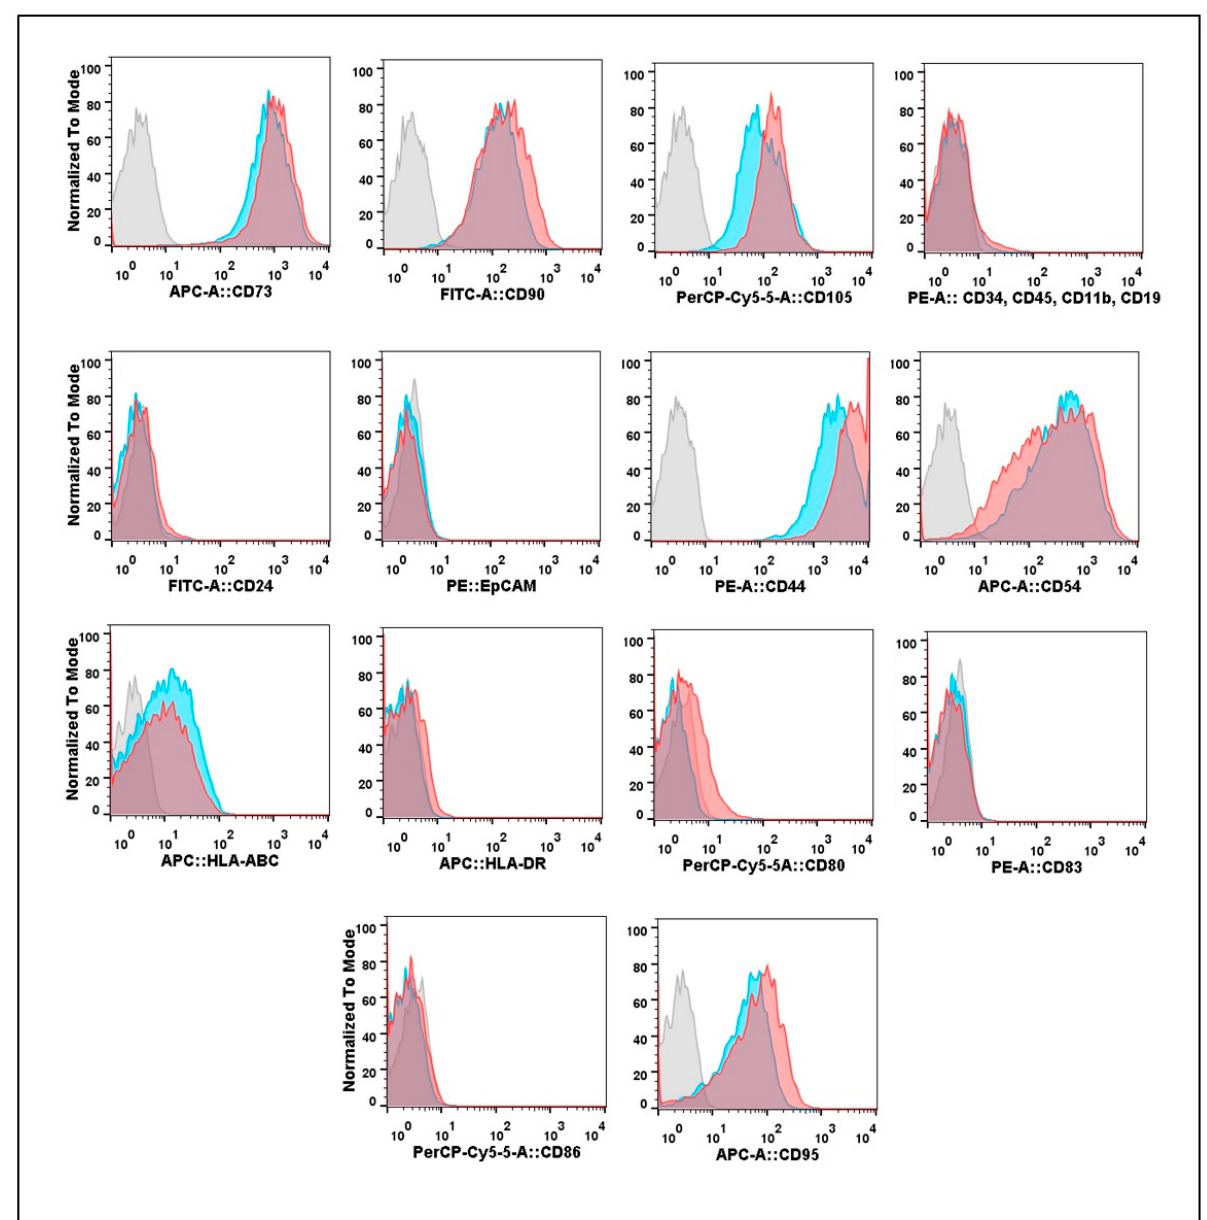
Figure 2. Expression of surface molecular markers on the mesenchymal stromal cell (MSC) cultures isolated from eutopic endometrium (eMSC) and endometrioid heterotopias (gMSC). Cell suspensions were treated with fluorochrome-conjugated monoclonal antibodies (MoAbs) and analyzed by flow cytometry X -axis—fluorescence intensity; Y -axis—normalized to mode percentage of cells. Blue curves—eMSC-5; red curves—gMSC-5; gray curves—gMSC-5 isotypic control. Since there are no significant differences between gMSC and eMSC isotypic controls, the eMSCs isotypic control histograms are not shown.